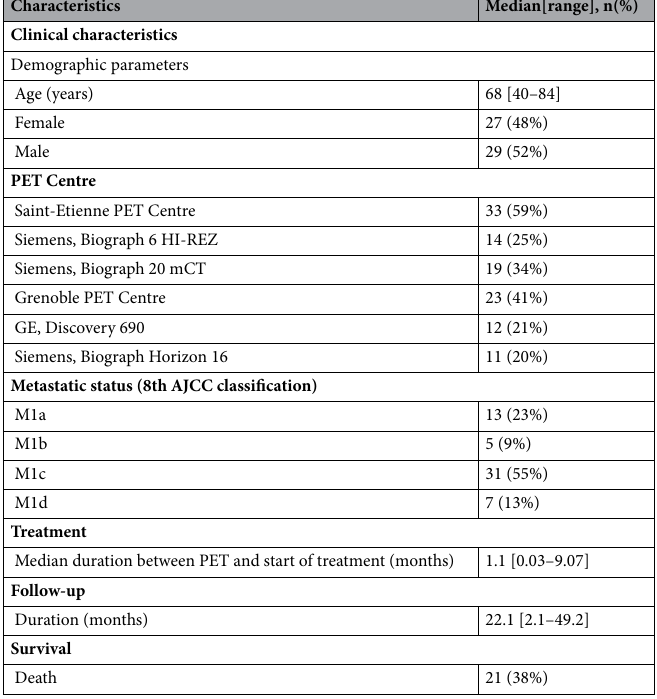
Table 2. Clinical characteristics of the patients (n = 56). SUV standardized uptake value, PET positron emission tomography, M Metastatic status (8th American Joint Committee on Cancer classification): M1a: distant metastasis to skin, soft tissue including muscles, and/or nonregional lymph. M1b: distant metastasis to lung with or without M1a sites of disease. M1c: distant metastasis to non-central nervous system (CNS) visceral sites with or without M1a or M1b sites of disease. M1d: distant metastasis to CNS with or without M1a, M1b, or M1c sites of